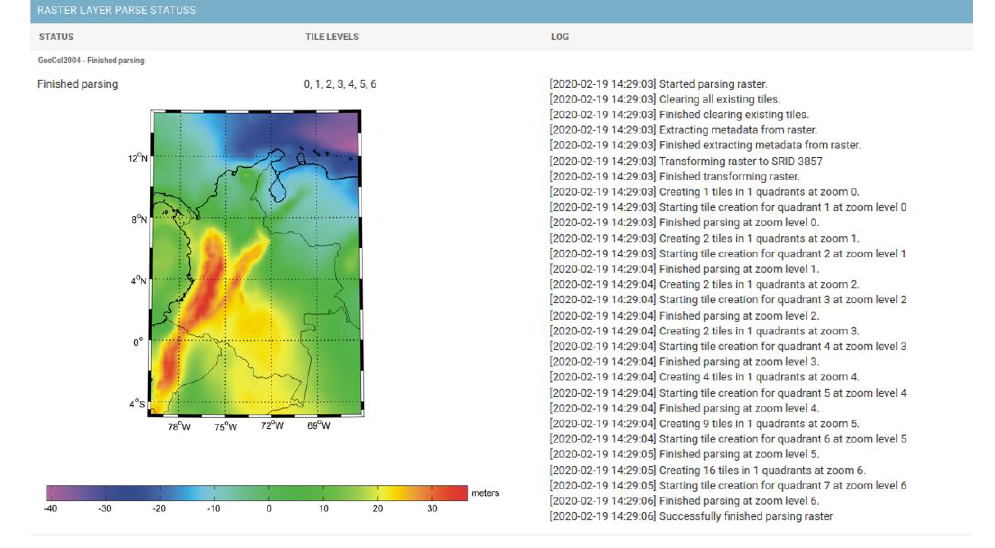
Figure 5. Geoid Model – Model tiling – Add product (2/3)